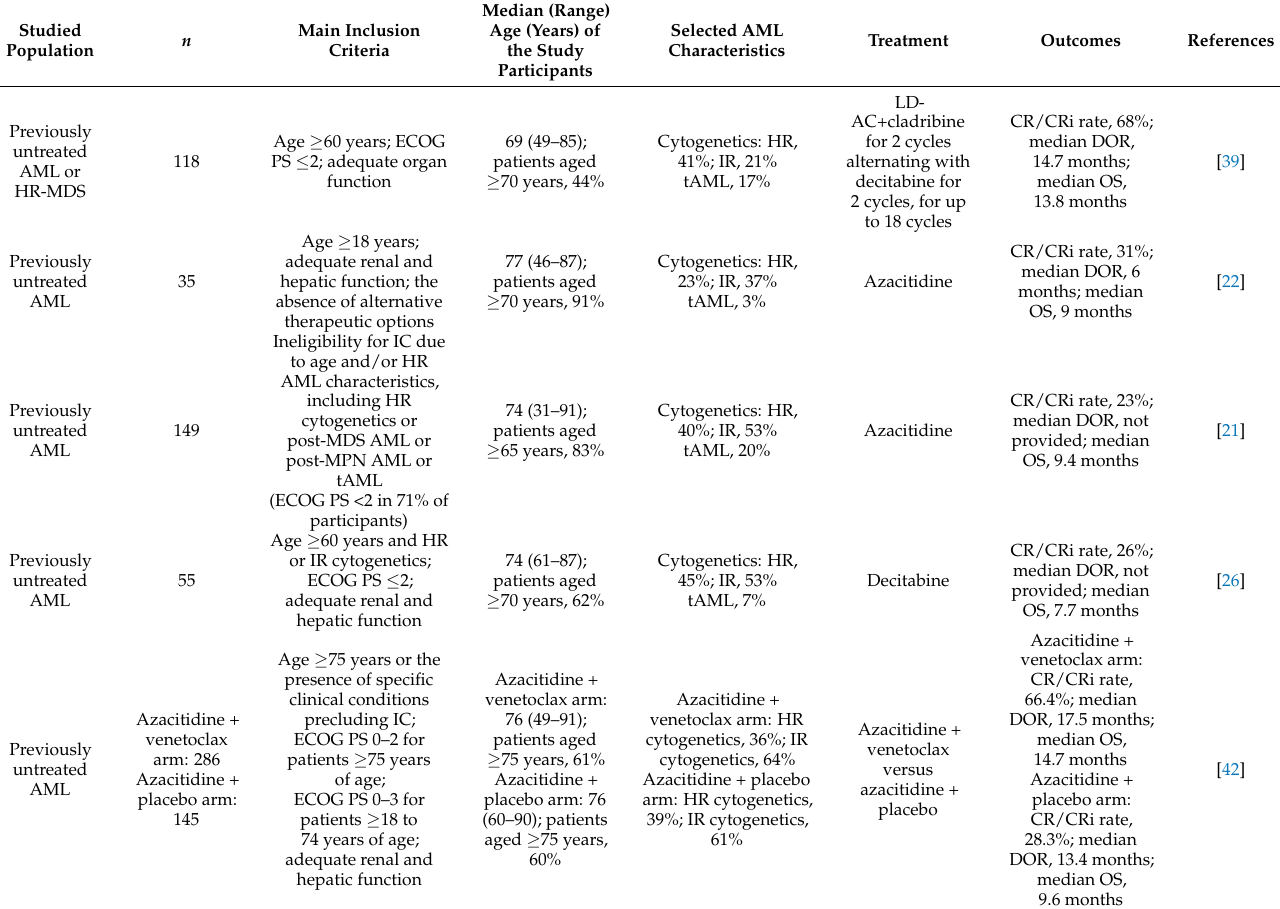
Table 5. Selected studies evaluating frontline treatment for unfit elderly AML